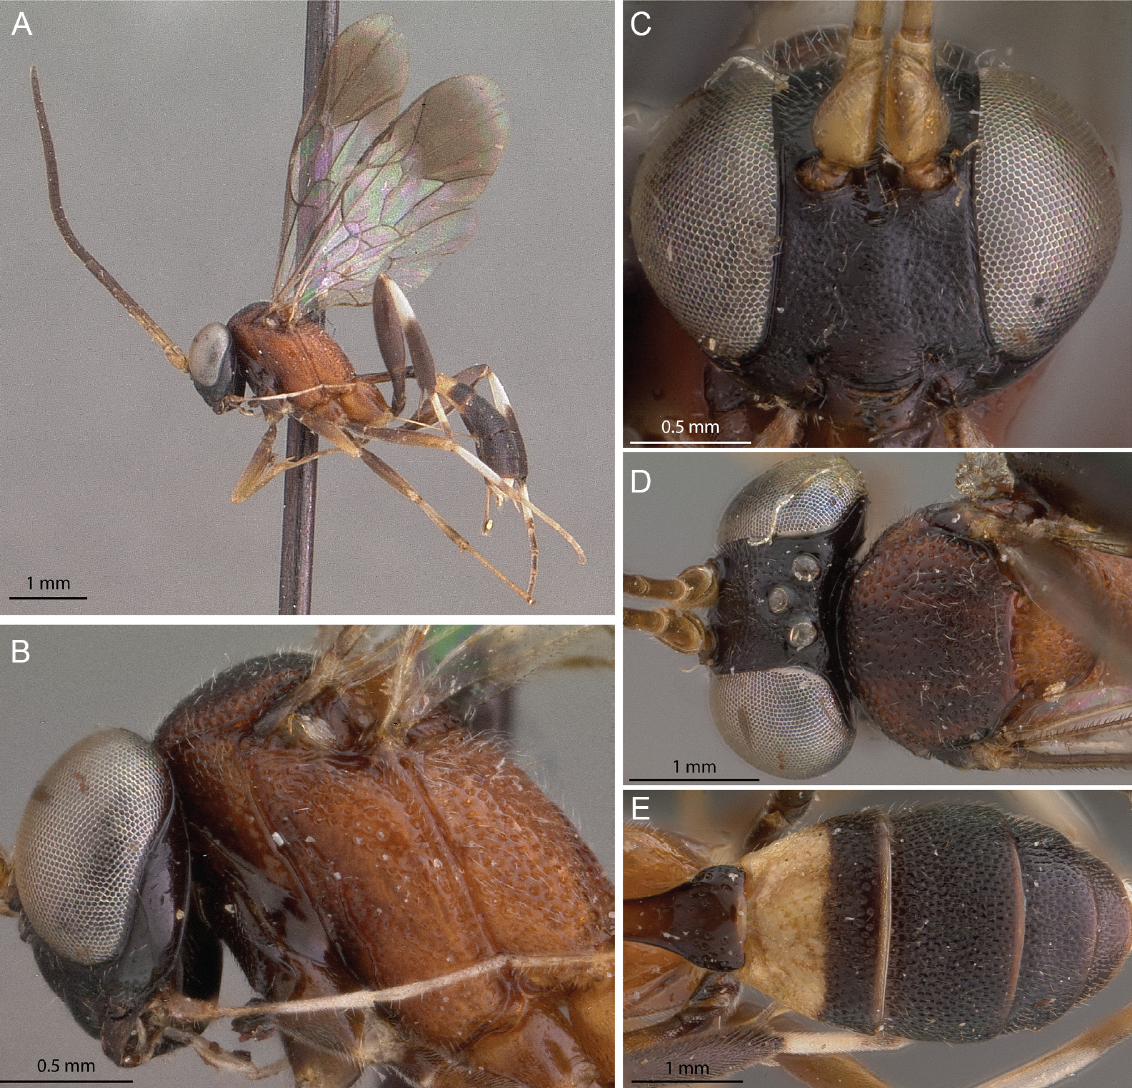
Fig. 25. Palpostilpnus rufinator (Aubert, 1961), holotype, ♀ (USUC) . A . Lateral habitus. B . Mesopleuron. C . Head, anterior view. D . Scutum. E . Metasoma, dorsal